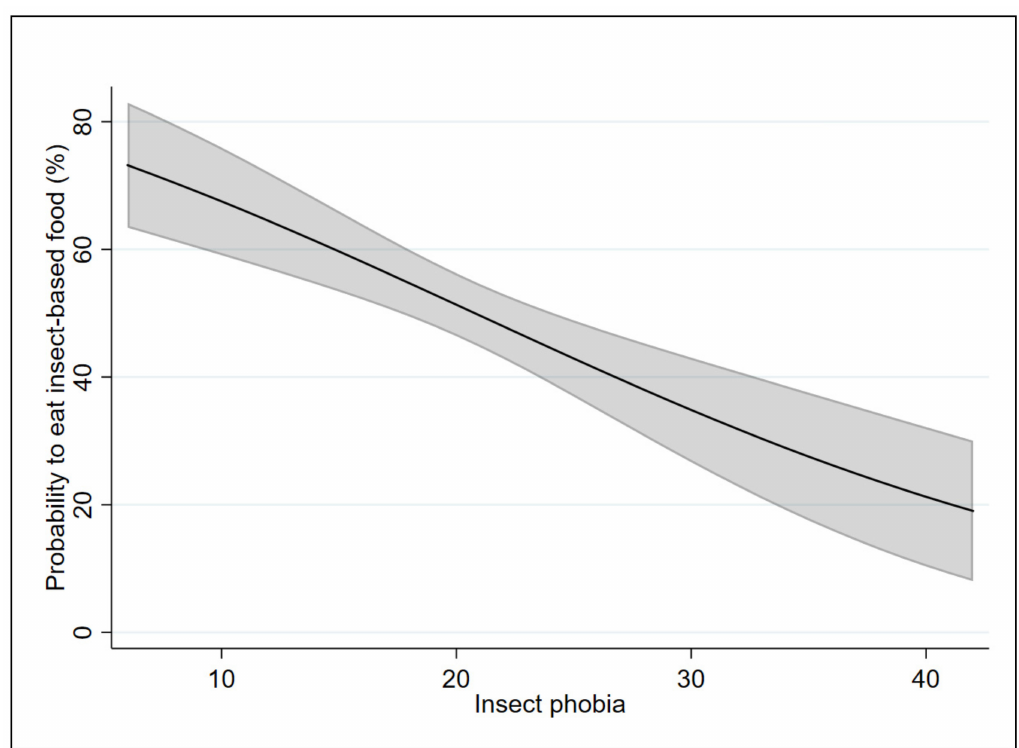
Figure 3. Marginal effects of the insect phobia scale on Model 1 with 95% confidence intervals.